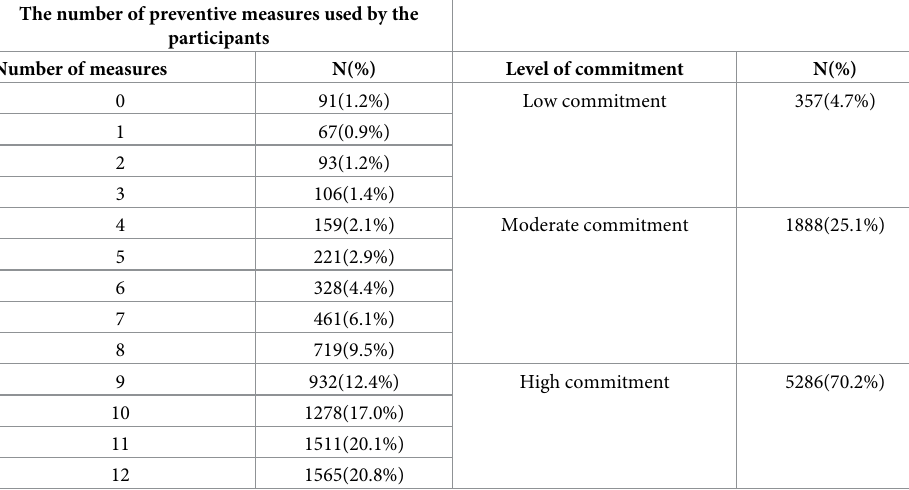
Table 3. Level of commitment to protective